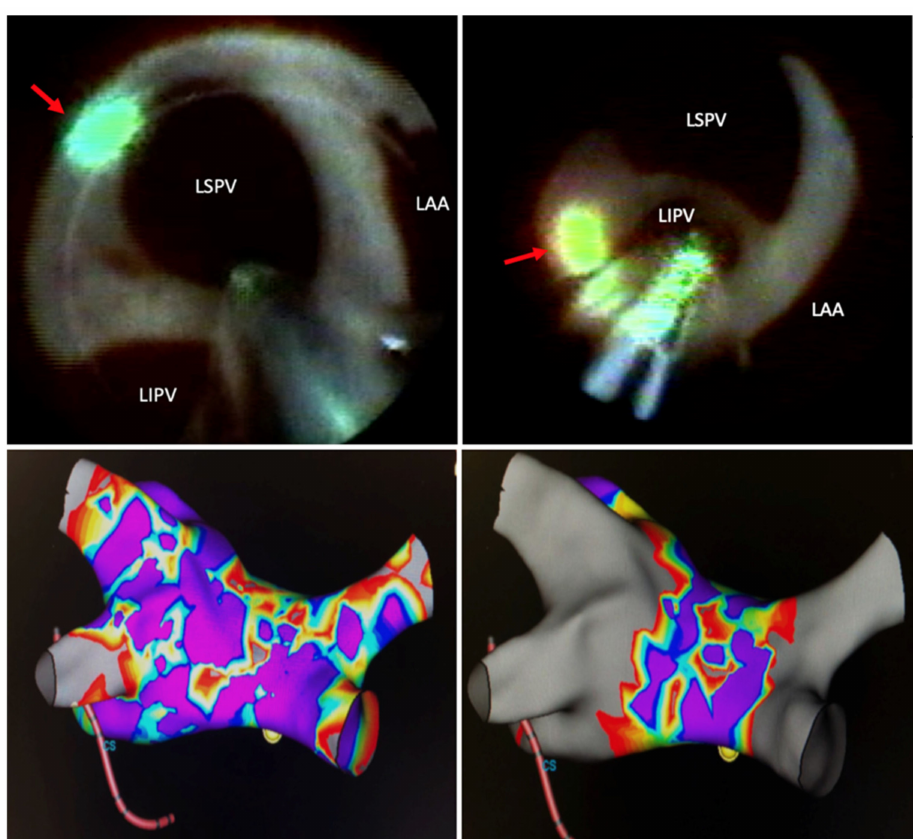
Figure 3. LSPV: left superior pulmonary vein; LIPV: left inferior pulmonary vein; LAA: left atrial appendage; red arrow: green-colored aiming beam of lesion generator. Top panels show endoscopic views during laser ablation of the LSPV and LIPV. Bottom panels show pre-ablation voltage map of left atrium and pulmonary veins ( left ) and post-ablation voltage map wide area antral isolation of the pulmonary veins ( right